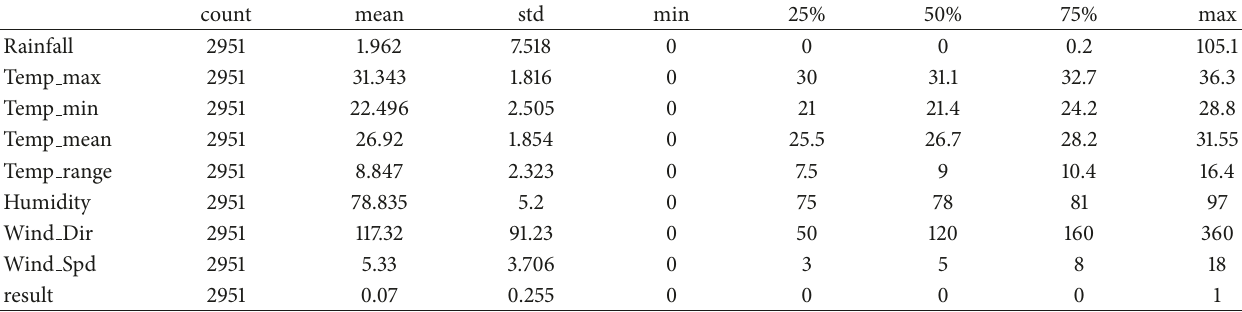
Table 3: Statistical data description of cholera cases using count, mean, std, min, max, and